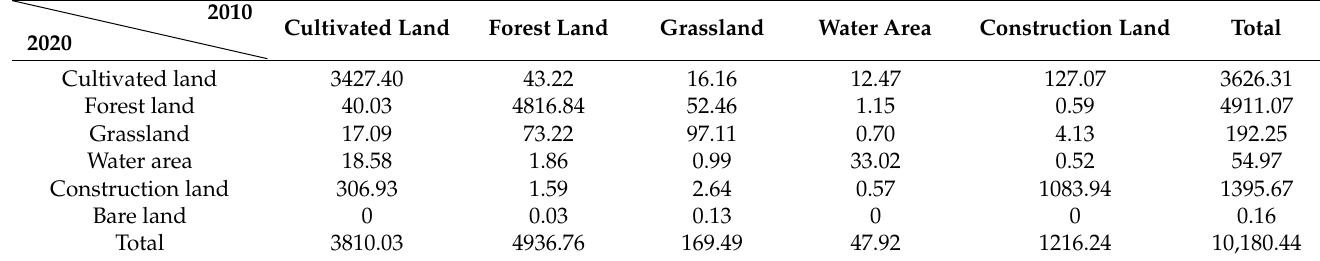
Table 12. The land use transfer matrix in Xi’an from 2010 to 2020 (unit: km 2 ).